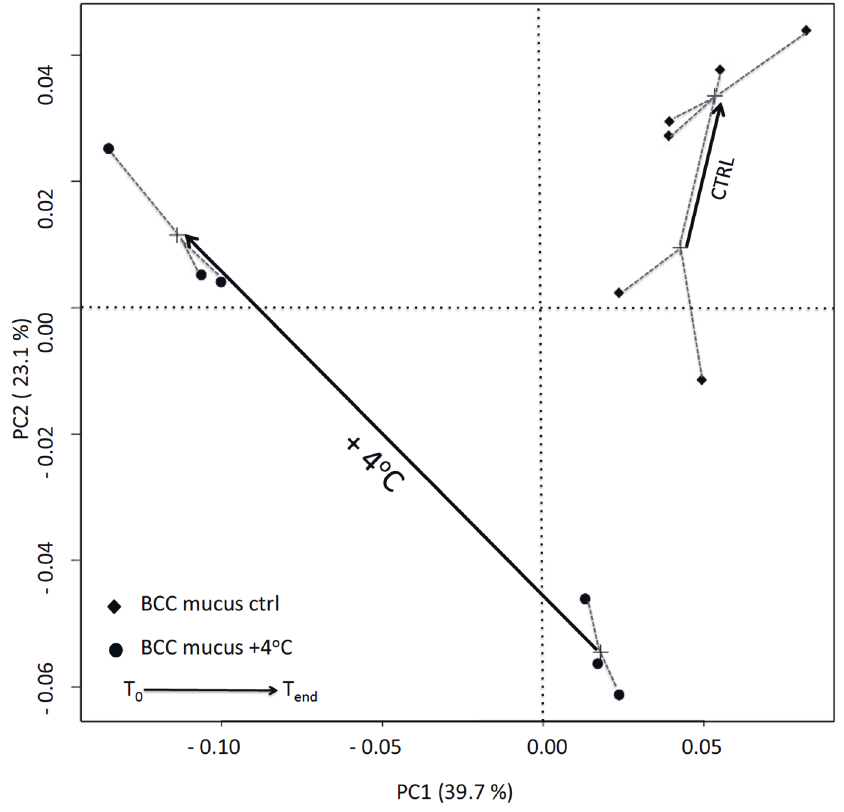
Figure 4. Principal component analysis (PCOA) obtained with the Sorensen dissimilarity index calculated from denaturing gradient gel electrophoresis (DGGE) presence/absence profile. Arrows, drawn from the calculated centroid of all replicates of each sample, show the evolution in the bacterial community structure between the beginning and the end of the experiment, in mucus samples of F. repanda , in both control (CTRL) and heat-treatment (+4